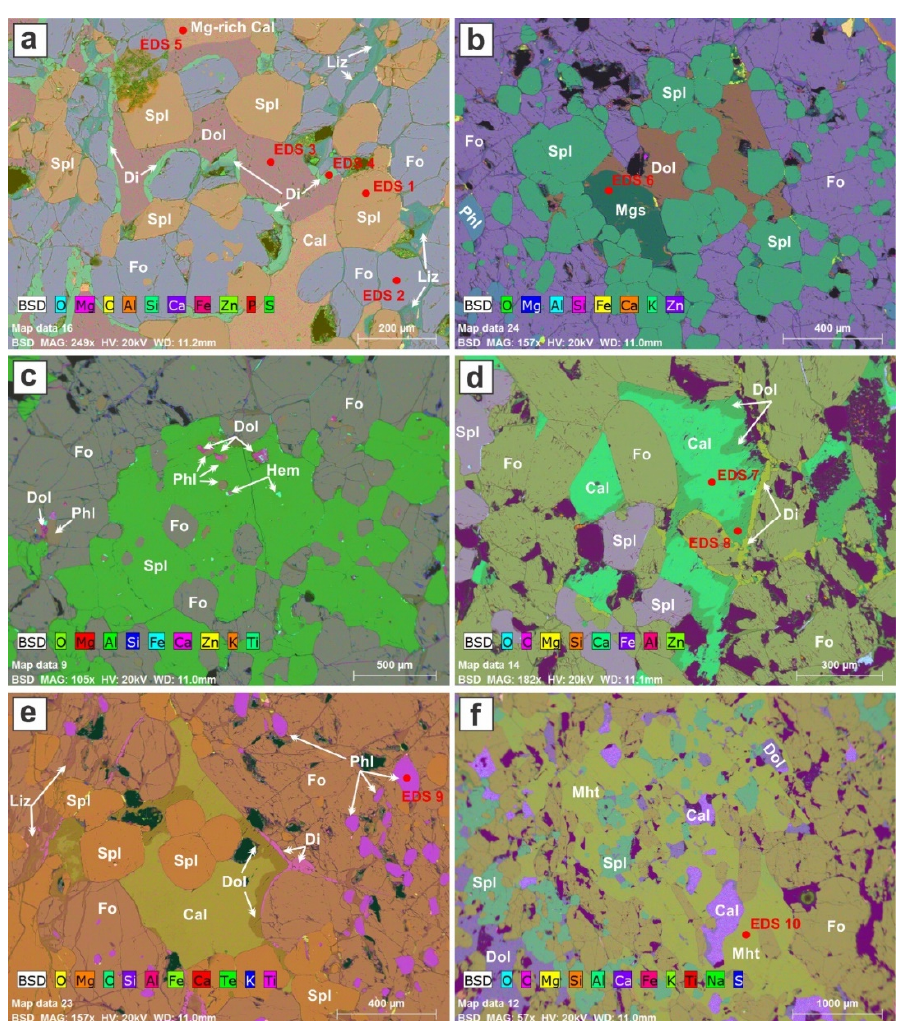
Figure 4. False-color energy-dispersive spectroscopy (EDS) element-distribution maps superimposed on the back-scattered electron images showing the texture of dunite in the two thin sections from the Parker mine. EDS point analyses 1 to 10 are shown in Figure S4. Symbols: Cal: Calcite; Di: Diopside; Dol: Dolomite; Fo: Forsterite; Hem: Hematite; Liz: Lizardite; Mht: Magnesio-hastingsite; Mgs: Magnesite; Phl: Phlogopite; Spl: Spinel.